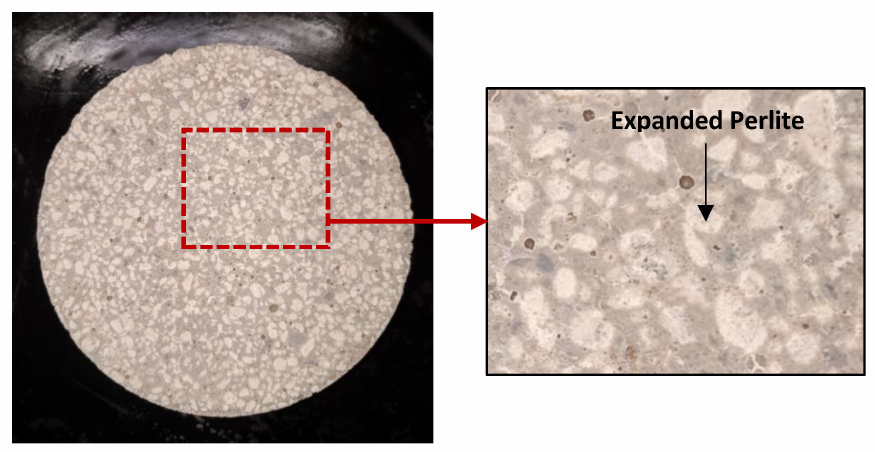
Figure 20. Cross-section of a C-PE mix cylinder specimen.